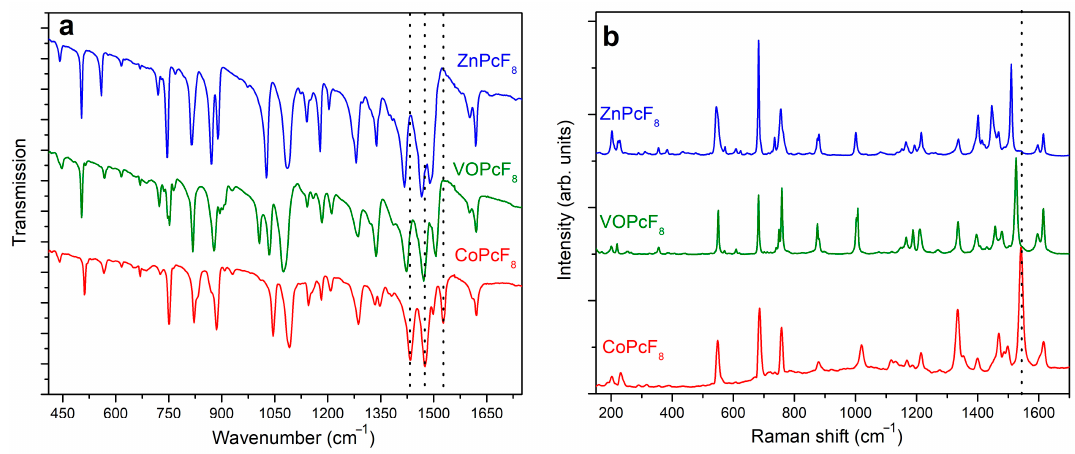
Figure 6. IR ( a ) and Raman ( b ) spectra of MPcF 8 (M=Co, VO,